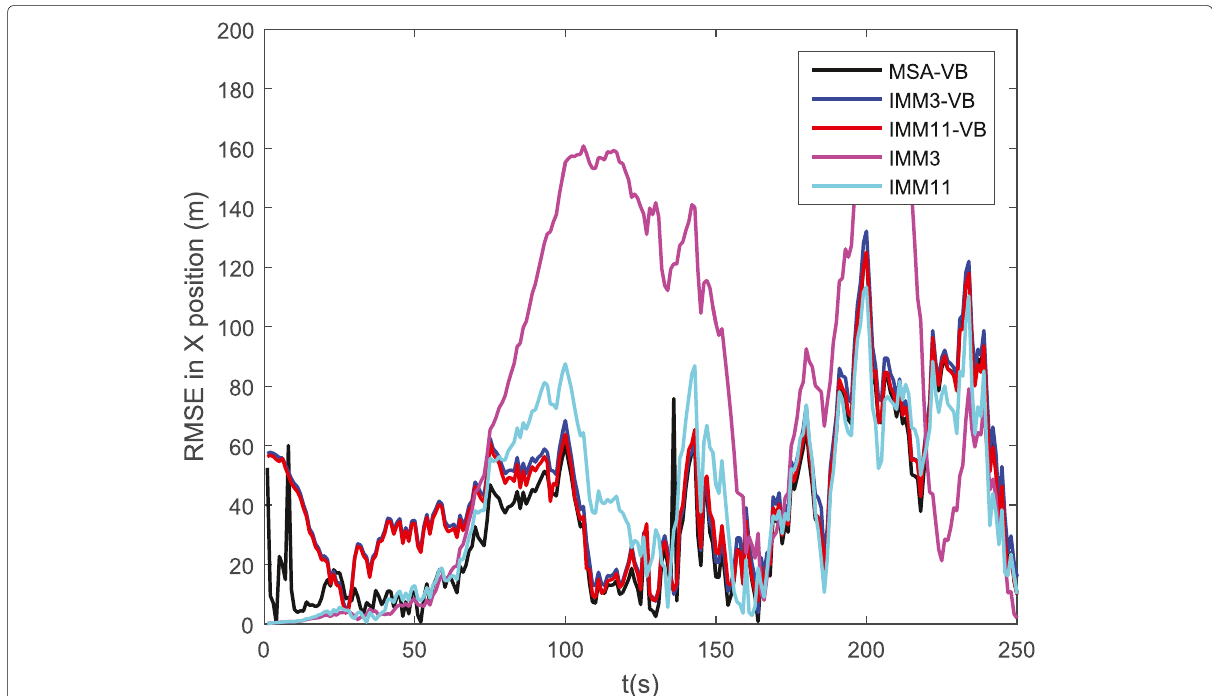
Fig. 1 RMSEs in X position of the proposed algorithm, IMM3, IMM11, IMM3-VB, and IMM11-VB in scenario 1